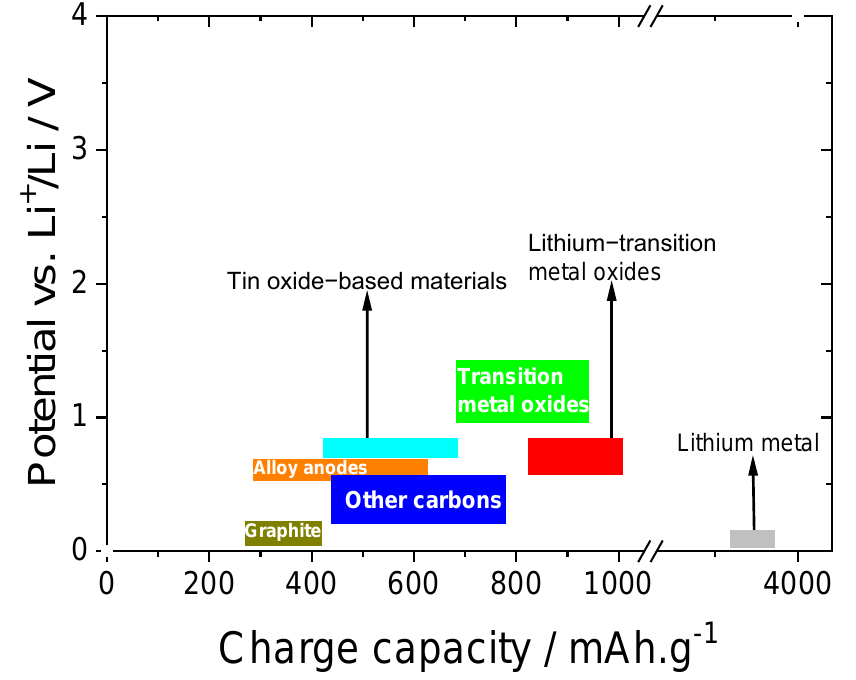
Figure 2. Voltage range vs. Li/Li + as a function of the charge capacity of different anode active materials (adapted from [61]) [59]).